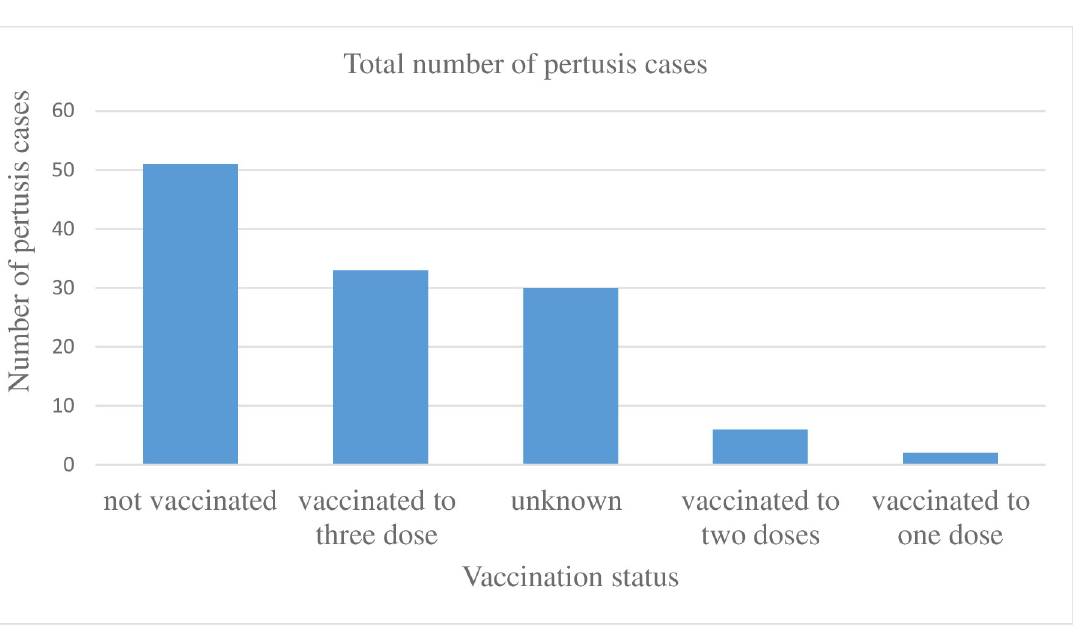
Fig 1. Vaccination status and pertussis cases in Gomengie and Seramre Kebele of Dahena district, 2019.